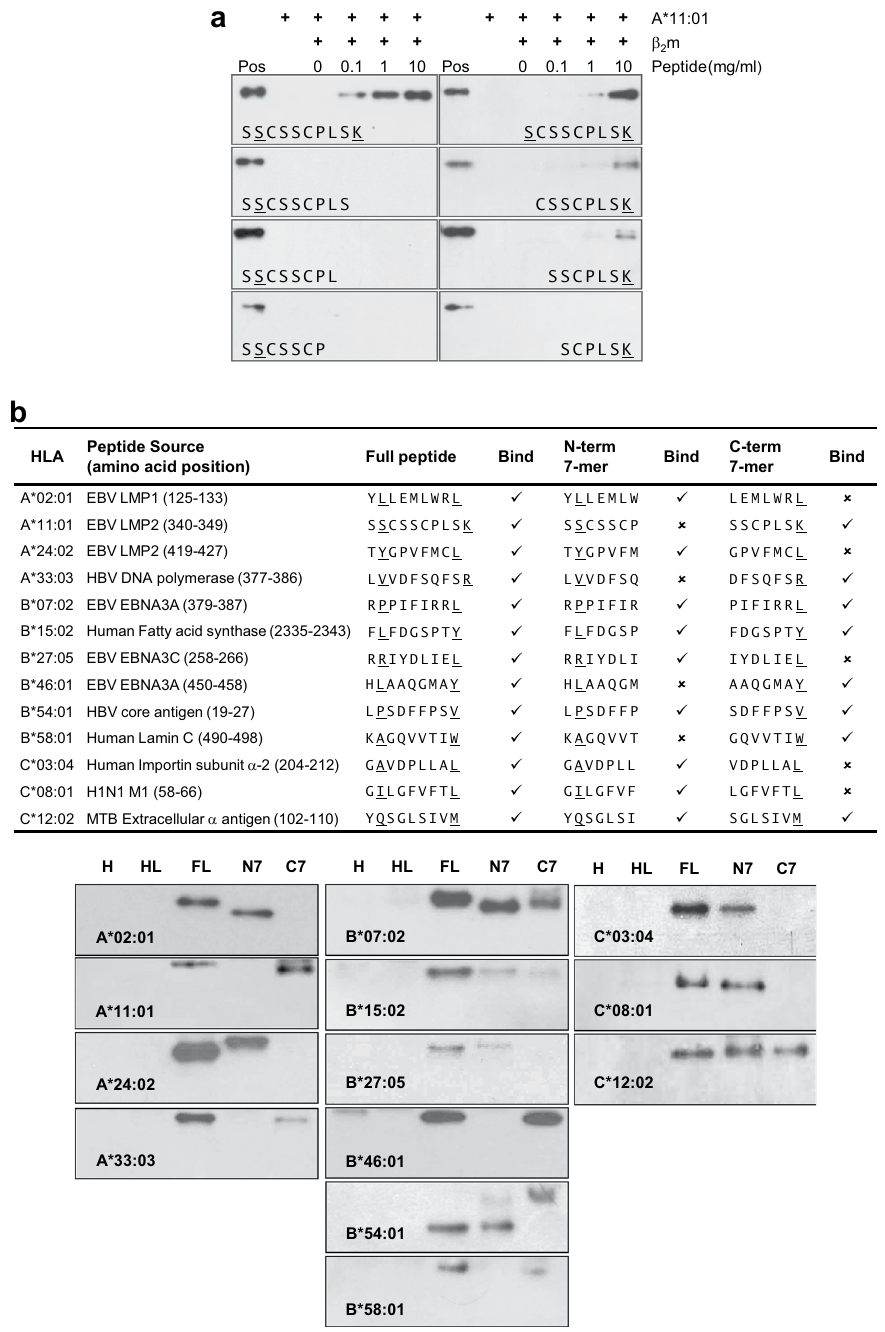
B*15:02 Human Fatty acid synthase (2335-2343) FLFDGSPTY